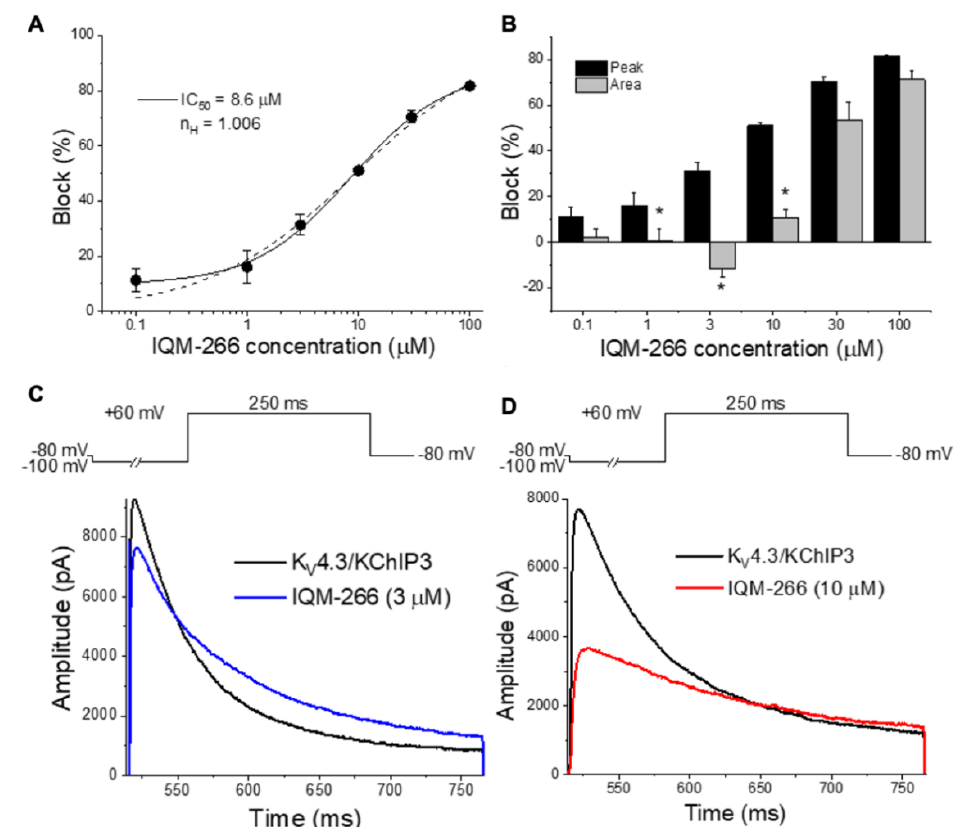
Figure 9. Concentration–dependence of inhibition and/or increase of the current or the charge through K V 4.3/KChIP3 channels produced by IQM-266 [70]. ( A ) Concentration–response curve of the effects of IQM-266 (continuous line) on K V 4.3/KChIP3 channels. The dashed line represents the fit of the data to a Hill equation with nH = 1 ( n = 34). ( B ) Effects on the current induced by IQM-266 in K V 4.3/KChIP3 channels at the peak current and in the charge (measured as the area of the current after applying 250 ms pulses to +60 mV; n = 34). ( C ) Current records of K V 4.3/KChIP3 to +60 mV in the absence and in the presence of IQM-266 (3 µ M). ( D ) Current records of K V 4.3/KChIP3 to +60 mV in the absence and in the presence of IQM-266 (10 µ M). * p < 0.05 when comparing the effect of IQM-266 on the peak current and on the charge through K V 4.3/KChIP3